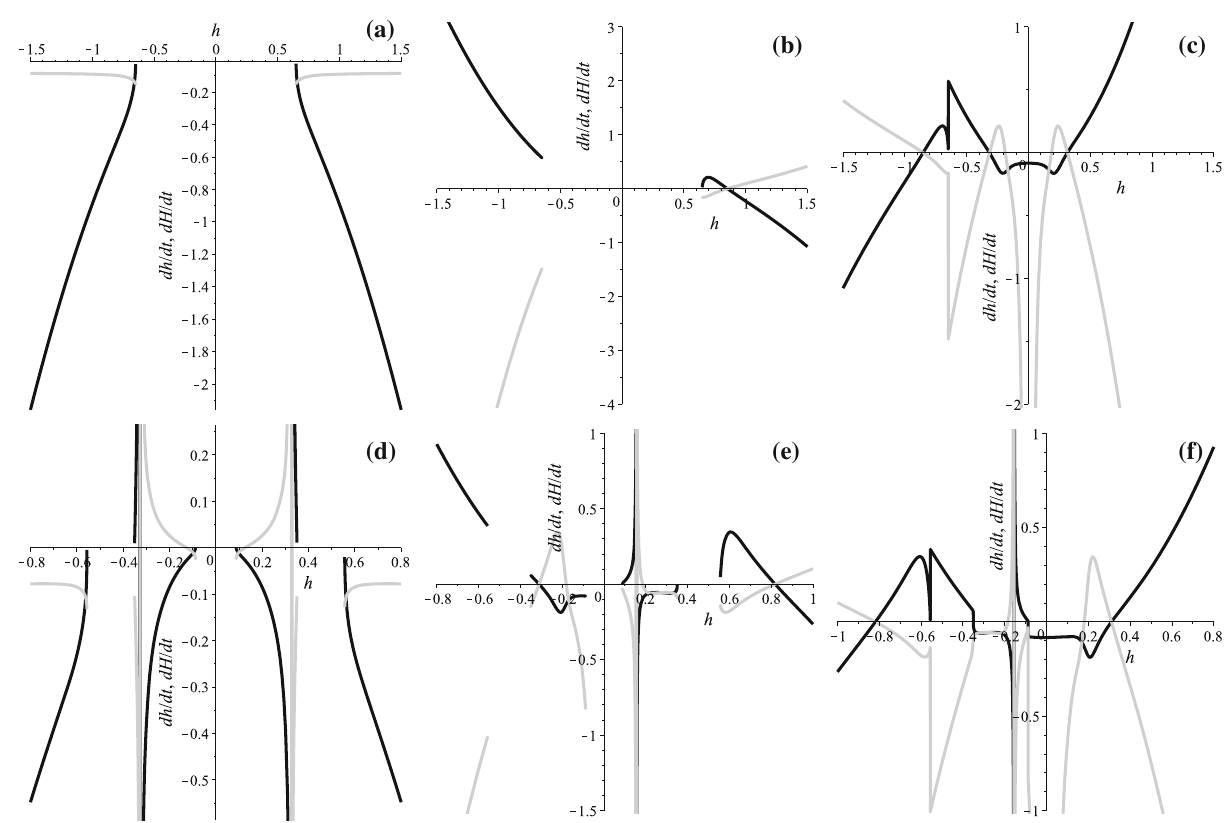
Fig. 3 ˙ h ( h ) ( black ) and ˙ H ( h ) ( gray ) curves for α > 0, (cid:2) < 0 D = 3 (cid:2) -term cases: ζ ≤ ζ cr on a – c and ζ > ζ cr on d – f . On a and d we presented the H 1 branch, on b and e – H 2 and on c and f – H 3 (see the text for more details)